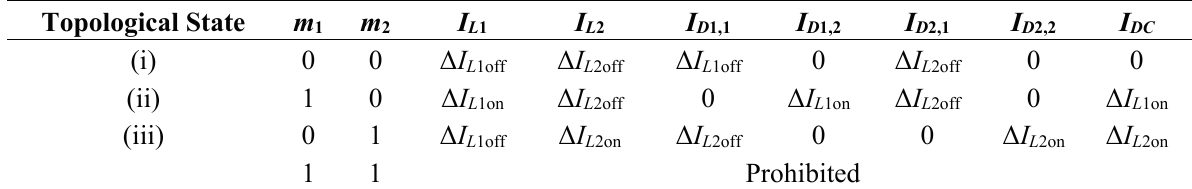
Table 2. Topological states for buck converters.